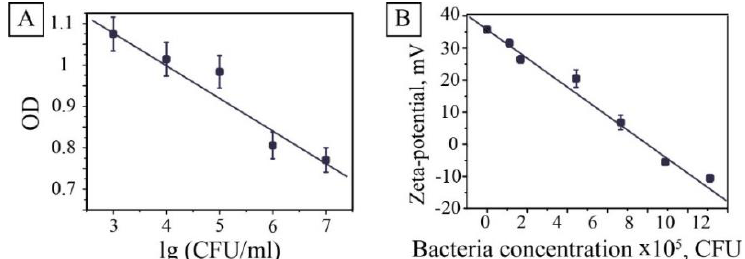
Figure 4. The effect of bacteria on peroxidase activity and colloidal stability of a solution of magnetite nanoparticles. Relationship of the optical density of the reaction mixture vs. decimal logarithm of the concentration of added E. coli. after 4 min of incubation ( A ); dependence of MNPs zeta potential against E.coli concentration ( B ).